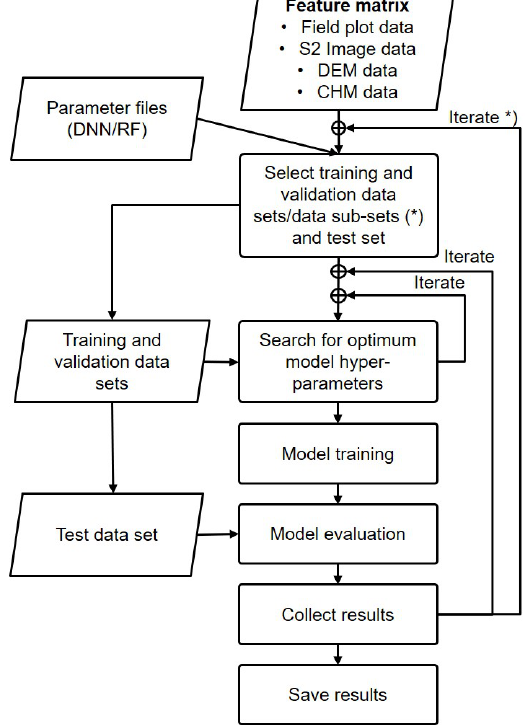
Figure 2. Flowchart of the iteration wrapper used in tests. (*) Refers to iteration including subsets of whole training/validation data (i.e., tests with limited training data and transfer learning tests).